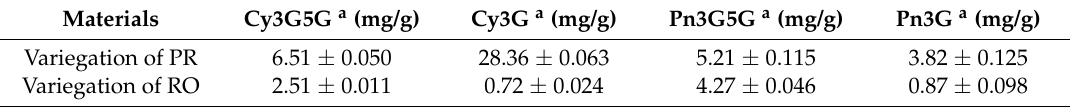
Table 2. The contents of anthocyanins in variegation of P. rockii and F1 progeny at fully open stage. Materials